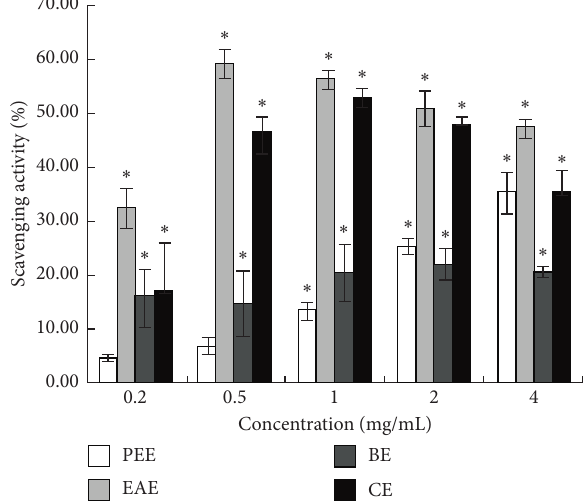
Figure 4: Hydroxyl radicals scavenging activity (%) of four ex- tracts. ∗ P < 0 . 05 vs. the blank group.